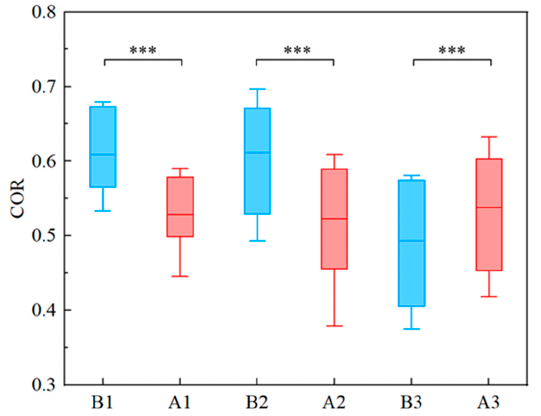
Figure 2. Comparison of the mean COR before and after the work shifts among three groups. Note: *** indicates that the results passed paired t -test ( p < 0.001).